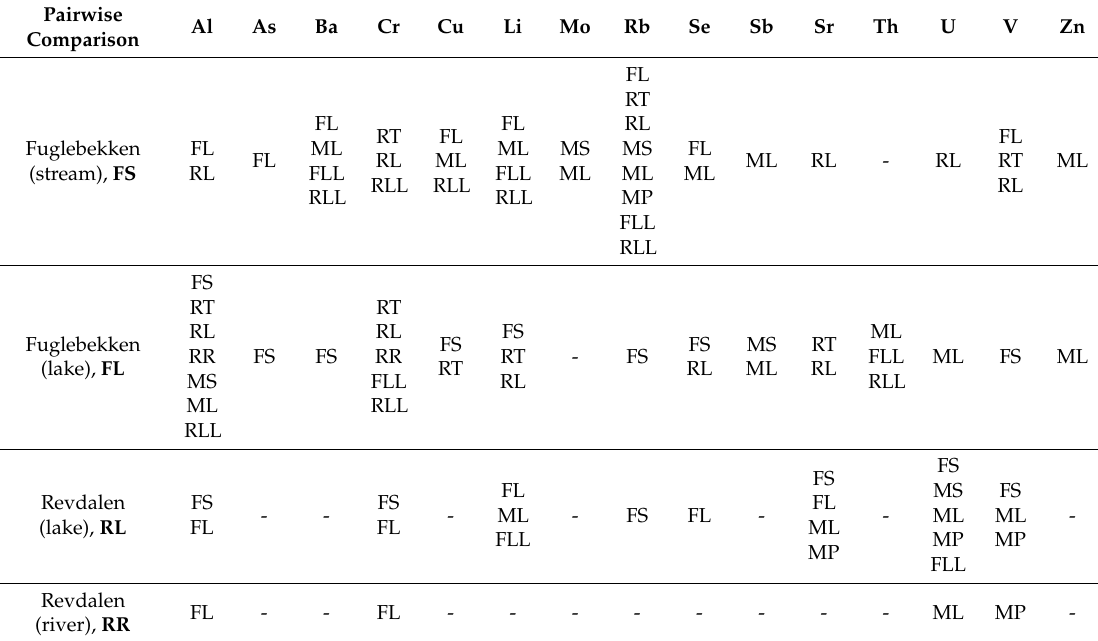
Figure 3. A box-and-whisker plot of the metals and metalloids concentrations measured in the freshwater environments in the Hornsund area, divided according to their concentration range into four graphs. All Y-axes are logarithmic scale. The box spans the interquartile range (Q 1 − Q 3 ), with median (Q 2 ) as a marker inside the box. Whiskers show the range of results except outliers, which are defined as values further than 1.5 interquartile range above Q 3 or below Q 1 . Table 1. Statistically significant di ff erences between water bodies in the Hornsund area with respect to metal and metalloid concentrations (according to Kruskal–Wallis ANOVA, p < 0.05). Pb not listed due to lack of significant di ff erences between any of the water bodies.